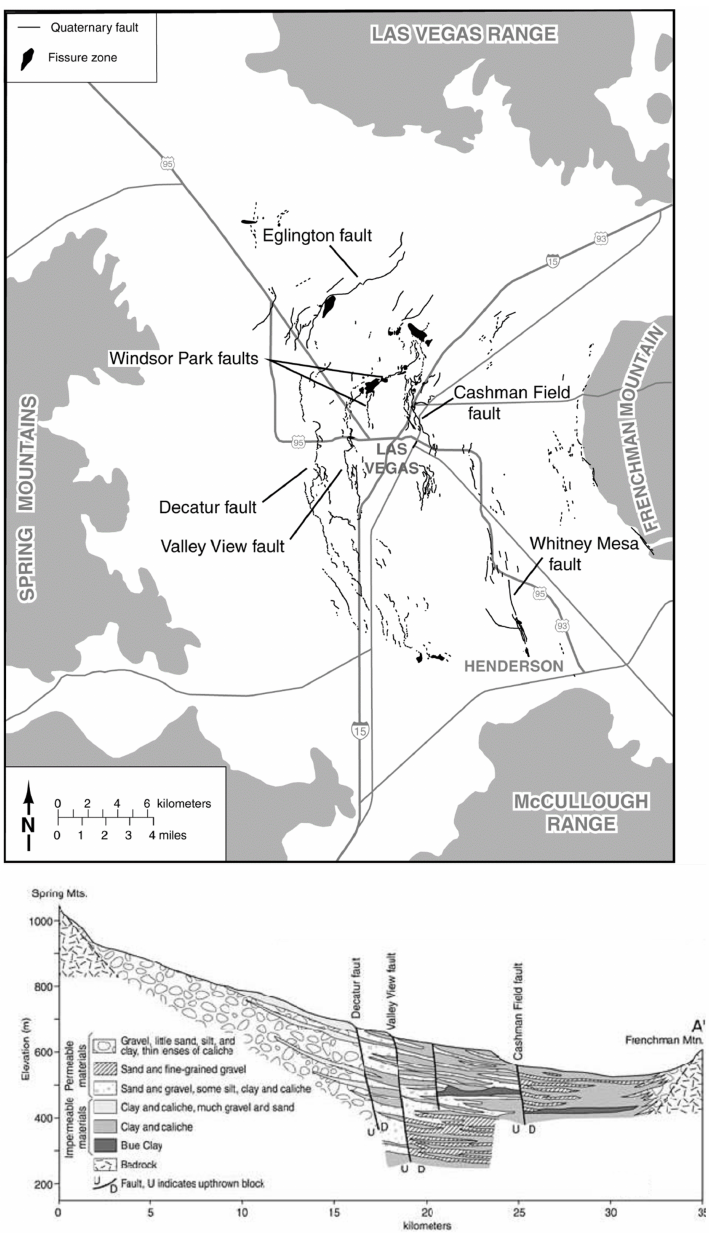
Figure 1. Site map showing location of basin fill faults (top) and A–A (cid:48) cross section (bottom) through Las Vegas